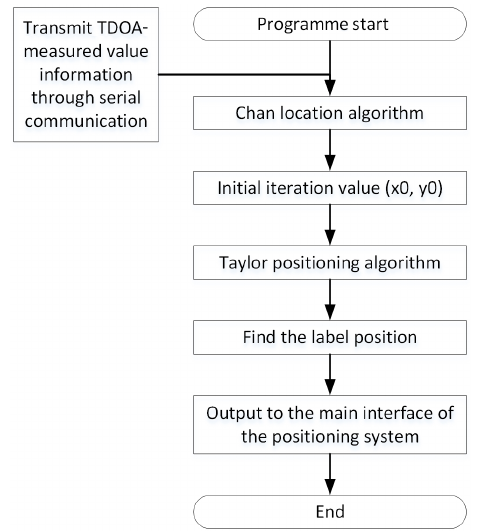
Figure 9. Calculation flow chart of the software positioning algo- rithm of the upper